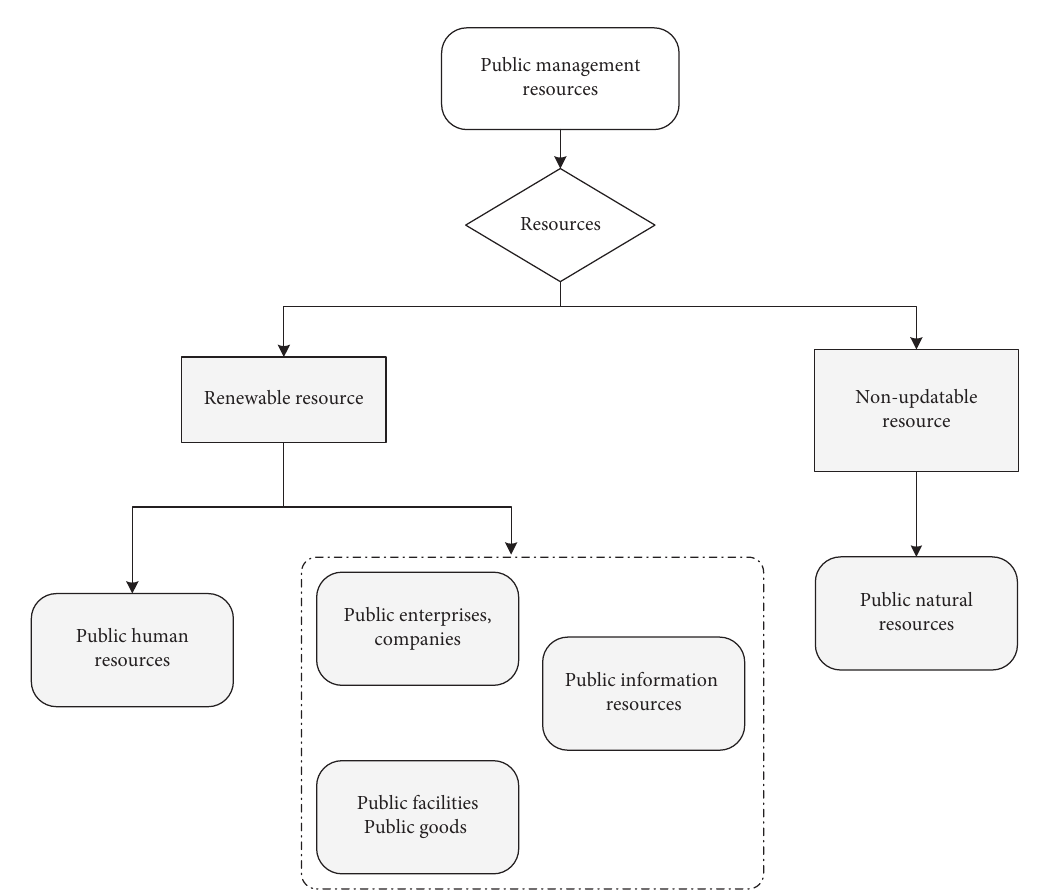
Figure 4: Resource classification according to common resource management